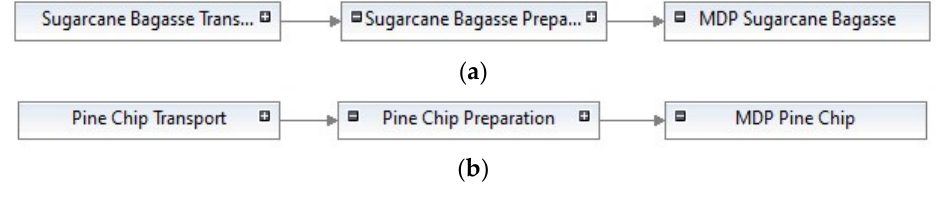
Figure 1. Modelling: ( a ) Scenario I and ( b ) Scenario II. For Scenario I, the calculated diesel input was 0.39 L of diesel for the transport of each ton of raw material. The calculation considered 3.4 km per litre of diesel, and the total distance of 8 km, being, therefore, 2.35 L of diesel consumed for the total capacity of 6 tons. As 1 ton was considered for the Functional Unit, the consumption to be considered was 0.39 L of diesel for each ton of sugarcane bagasse transported. The outputs were atmospheric emissions from transport and the amount of sugarcane bagasse transported, as shown in Table